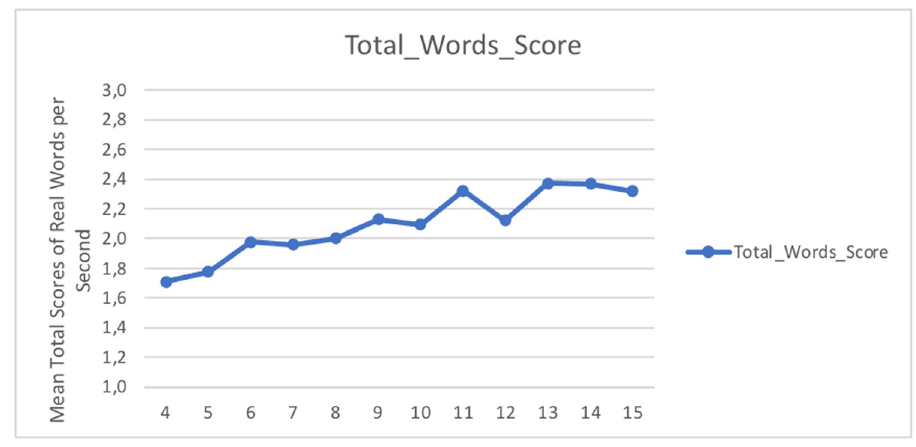
Figure 1: Total scores of real word stimuli per second by age.